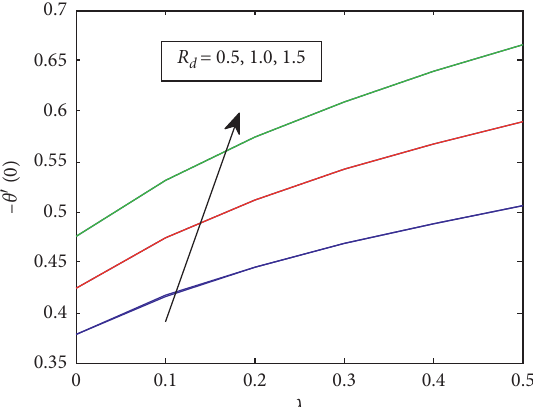
Figure 21: Local wall couple stress for different values of R λ .